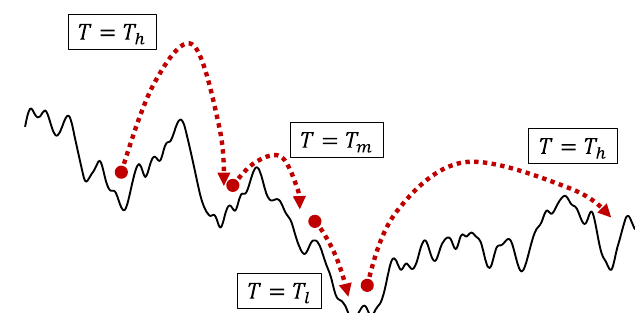
Fig. 6. Restart tempering method in rugged